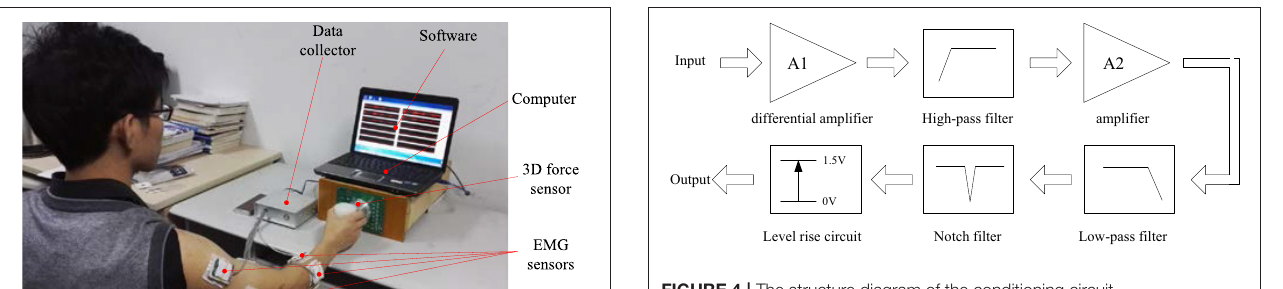
FIGURE 4 | The structure diagram of the conditioning circuit.